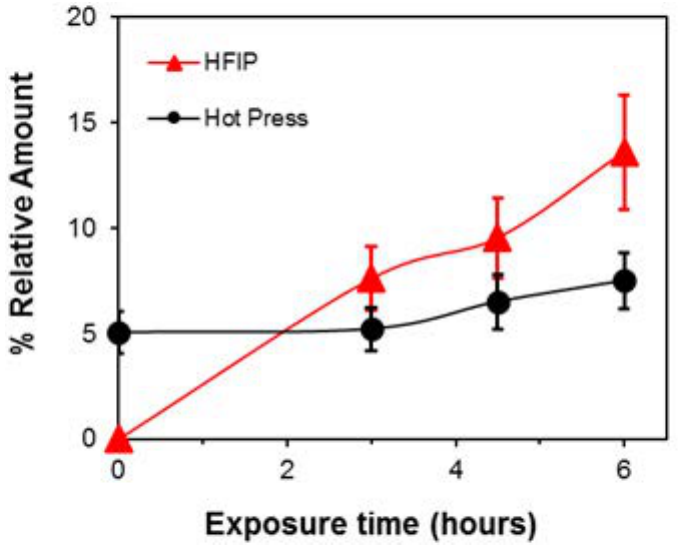
Figure 3. Relative amount (%) of a characteristic peak ( m / z 1154.20) derived from the photoreaction process as a function of time exposure in a film cast from HFIP and in a hot press molded